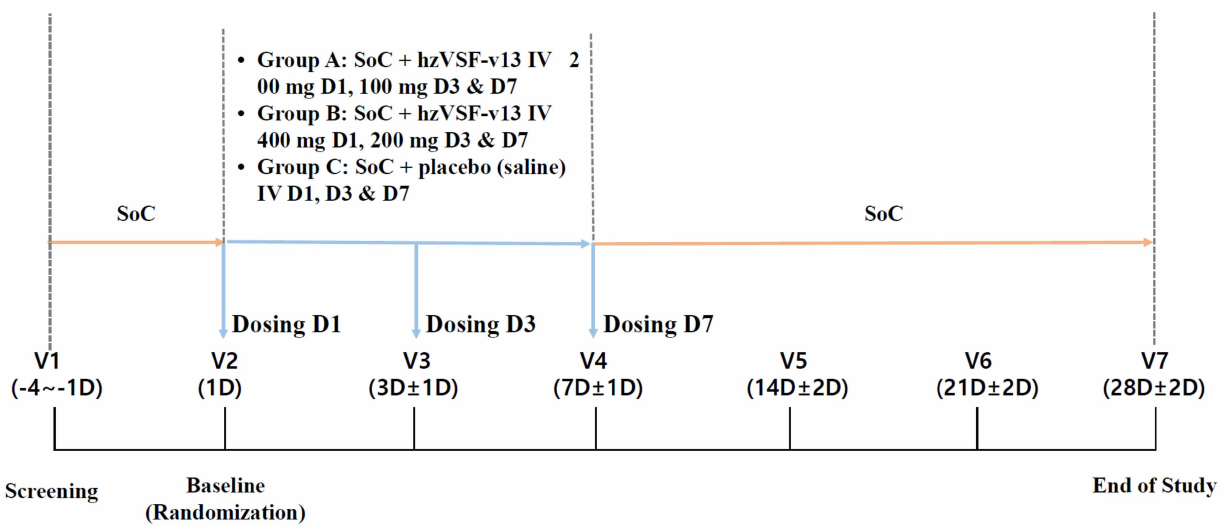
Figure 1. Study design (SoC = standard of care, D =